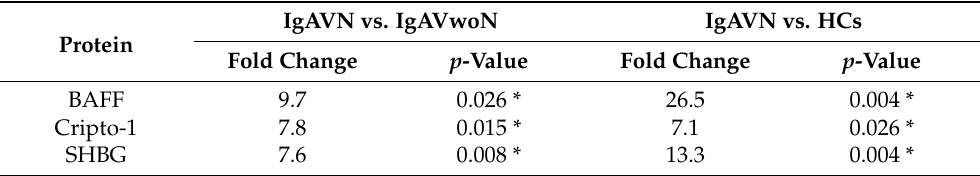
Figure 2. Volcano plots of IgAVN vs. IgAVwoN: ( a ) Kit K; ( b ) Kit C. The horizontal lines represent the statistical significance cut off ( − log10(0.05)). Vertical lines represent the fold-change cut-off (log2(0.5) − log2(2.0)). Table 2. A summary of the urinary proteins that were statistically significantly changed in both assays combined as sorted in order of descending fold change (IgAVN vs. IgAVwoN). Bold text represents duplicated proteins that were measured in both kits where results from Kit C are reported. * p < 0.05.